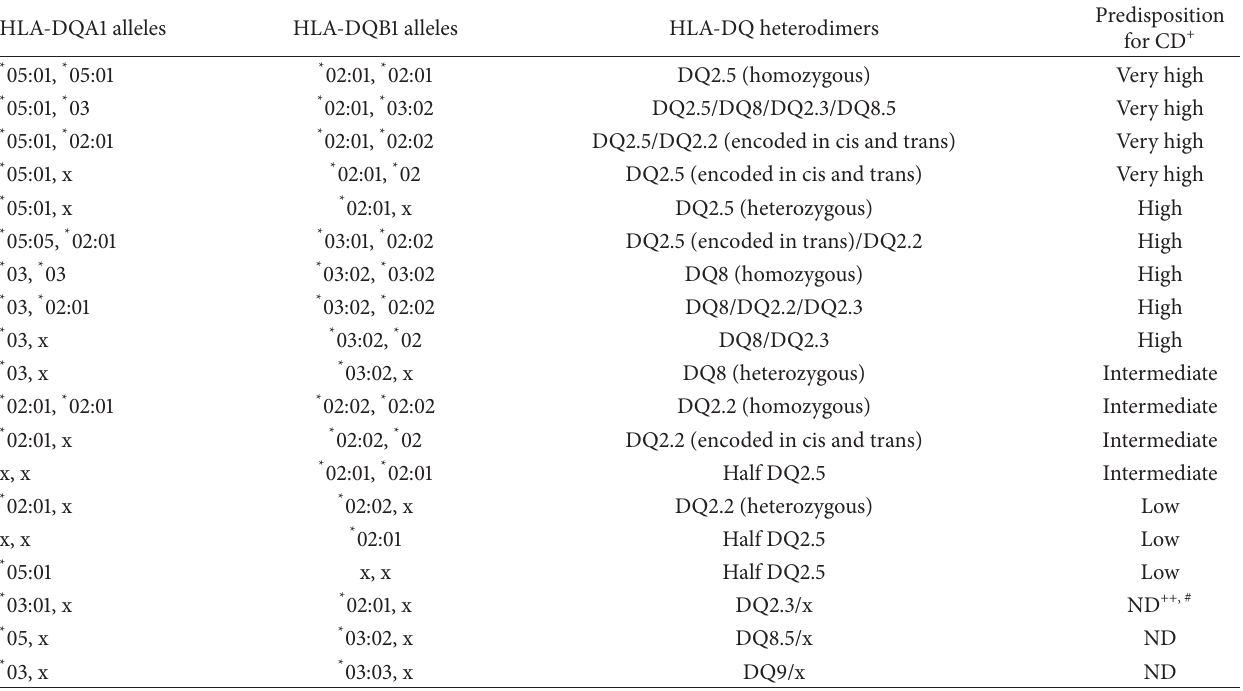
Table 2: HLA genetics and risk associated with